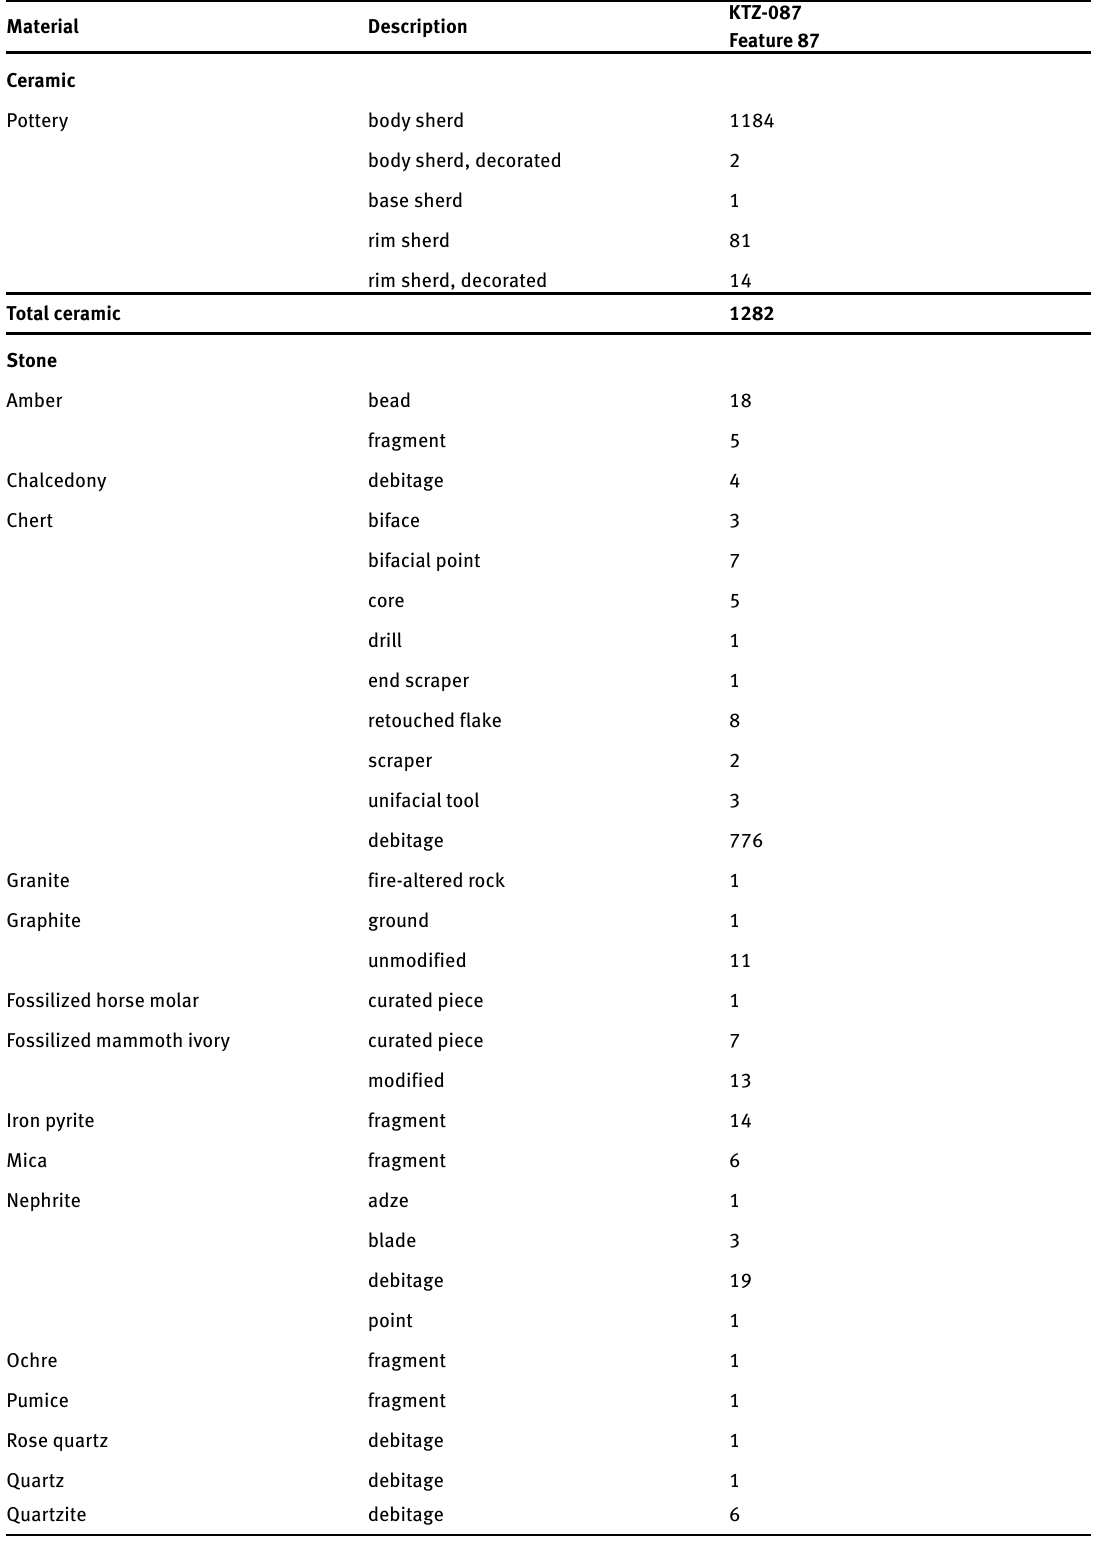
Table 2: Artifacts associated with Feature 87, recovered from 2011